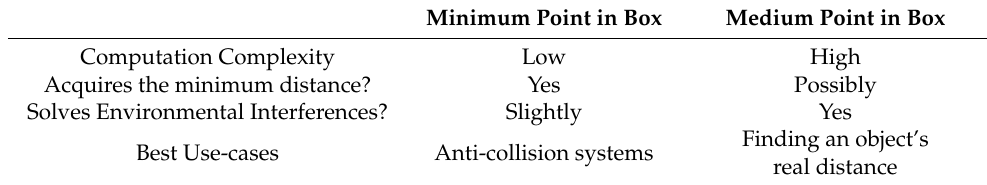
Table 1. Using the minimum point and the medium points within the bounding box: a comparison.